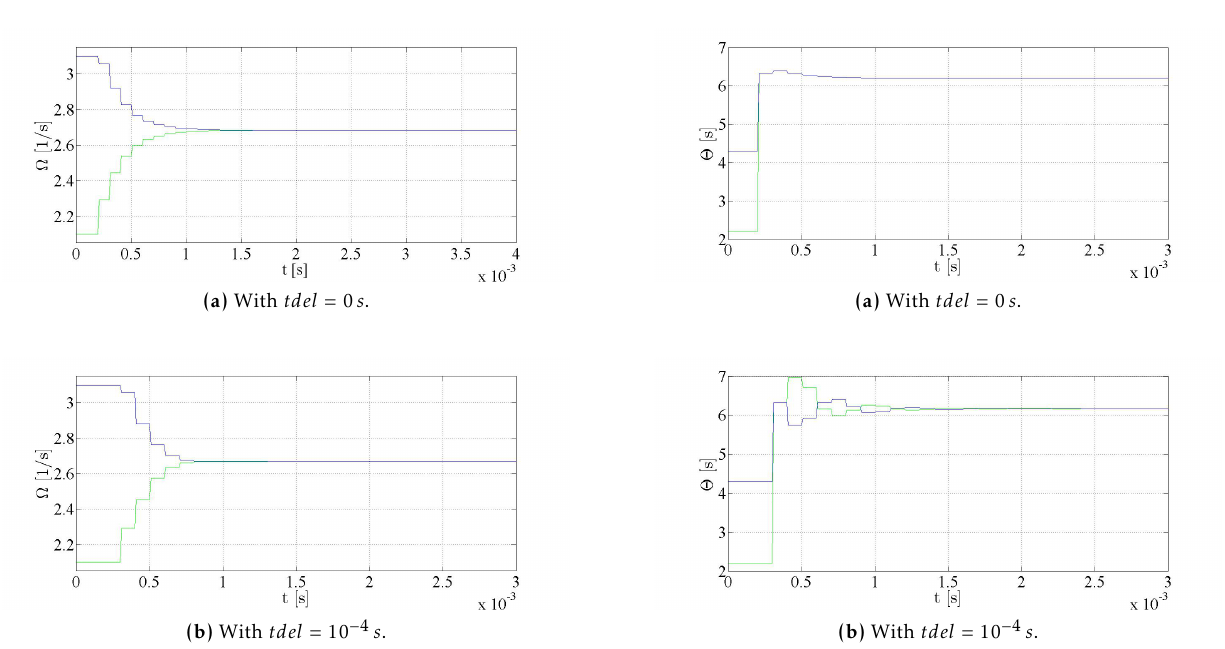
configurations, the system convergence is reached in less than 2 ms.